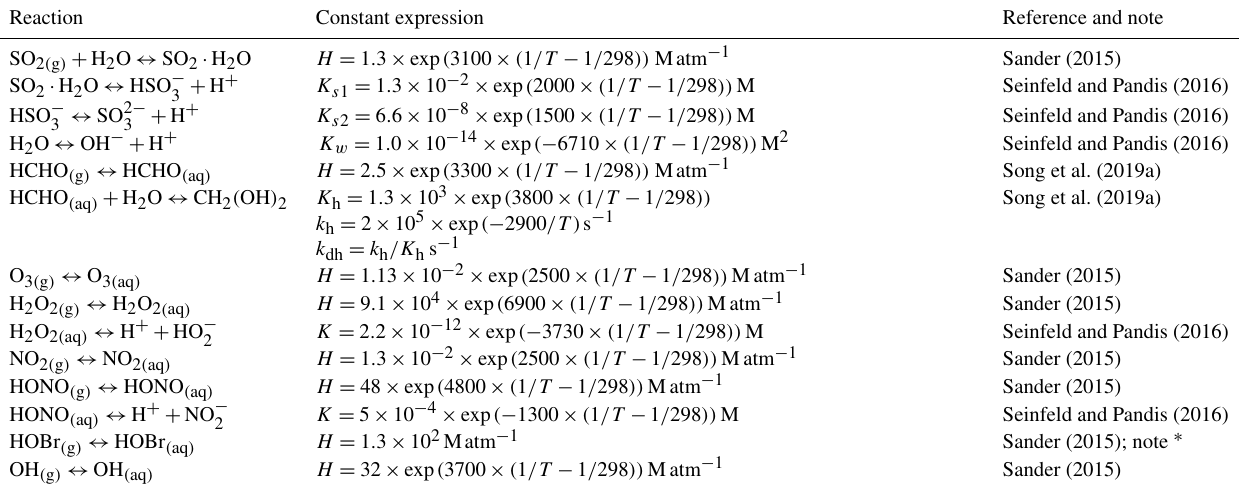
Table 2. Equilibrium reactions.